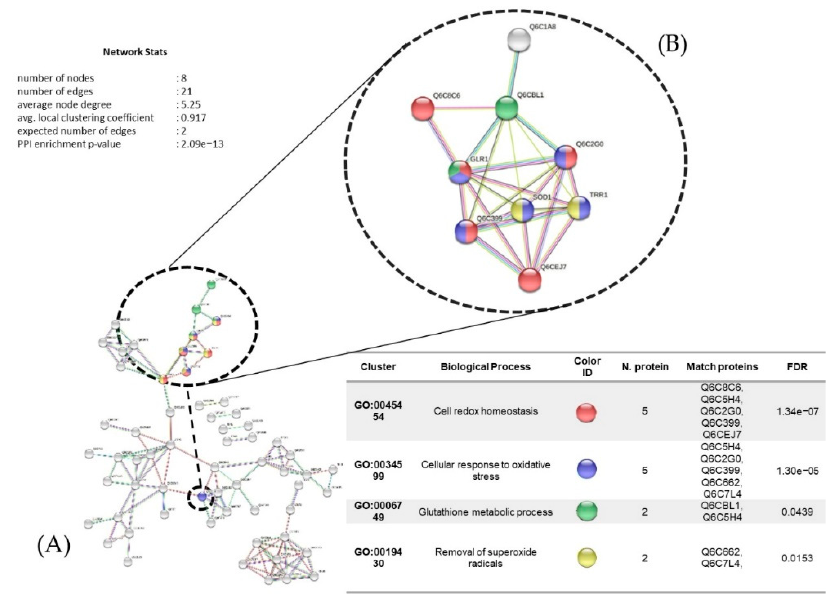
Figure 12 . ( A ) Protein interaction networks (upregulated) of Y. lipolytica AMJ6 related to biological processes in the copper (Cu +2 ) treatment. ( B ) Proteins related to the response to oxidative stress, cellular response to chemical stimulus, and response to ROS.